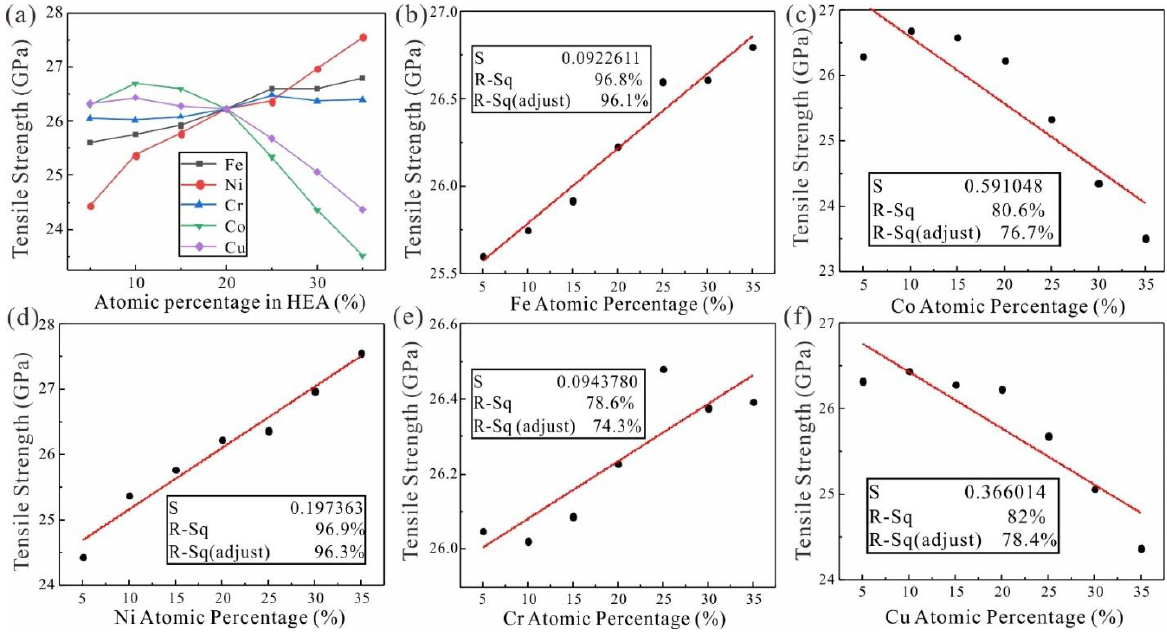
Figure 2. ( a ) Linear correlation between tensile strength of principal elements of FeNiCrCoCu HEAs with unequal atomic ratio, ( b ) Fe, ( c ) Ni, ( d ) Cr, ( e ) Co, ( f ) Cu and FeNiCrCoCu HEAs. S, R-Sq and R-Sq (adjust) represent the standard error, the goodness fit and the goodness fit adjusted for multiple parameters, respectively.